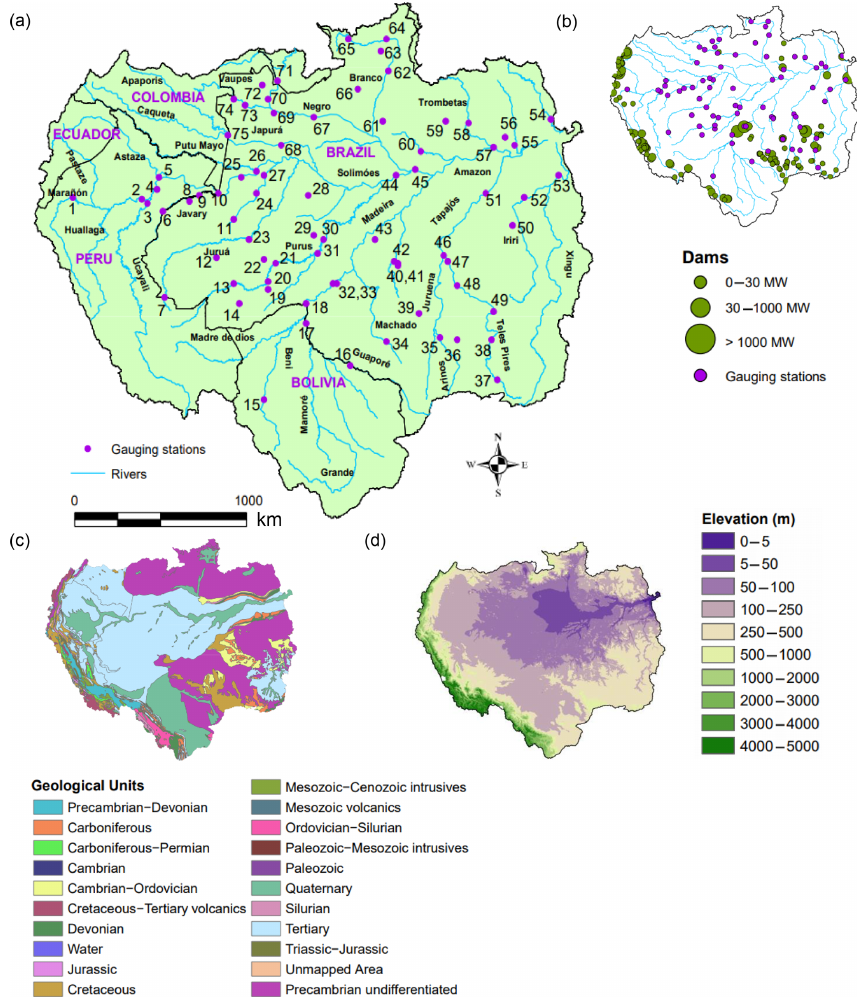
Figure 1. (a) Locations of the 75 hydrological gauges and the river network of the Amazon basin. Numbers represent stations which are referred to throughout the main text in italics. For station information, see Table S1. (b) Locations of existing and under-construction dams as of 2017 (see Latrubesse et al., 2017). (c) Geological map of the Amazon (Schenk et al., 1999). (d) Elevation map of the basin from the digital elevation model (DEM), GTOPO30, at a horizontal resolution of approximately 1km (US Geological Survey,